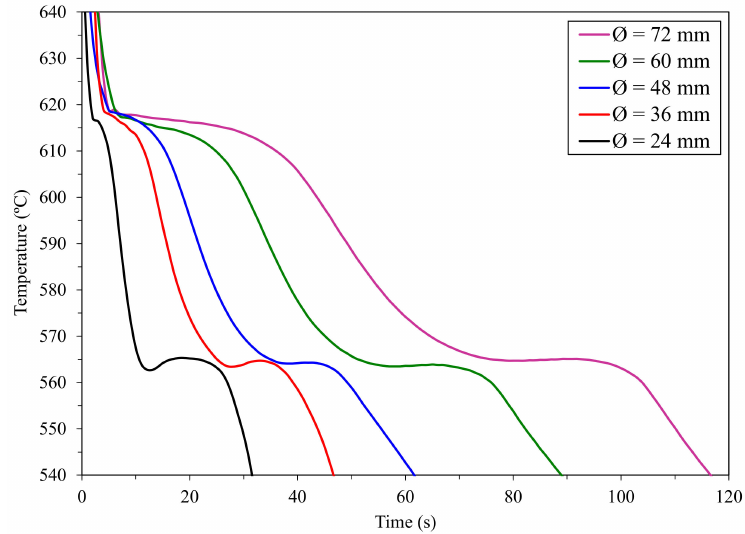
Figure 3. Different cooling curves obtained from the cylindrical test castings produced in one of the sets (data from